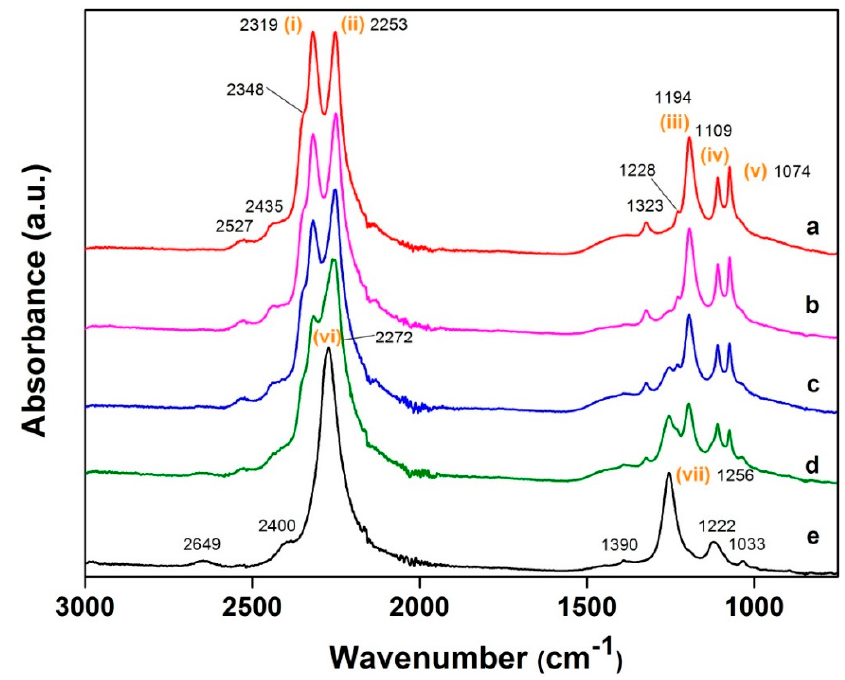
Figure 2. ATR-IR spectra of (a) Ca(BH 4 ) 2 , (b) 1Mg(BH 4 ) 2 : 2Ca(BH 4 ) 2 , (c) 1Mg(BH 4 ) 2 : 1Ca(BH 4 ) 2 , (d) 2Mg(BH 4 ) 2 : 1Ca(BH 4 ) 2 and (e) Mg(BH 4 ) 2 after ball milling. For bands labelling, see the text.